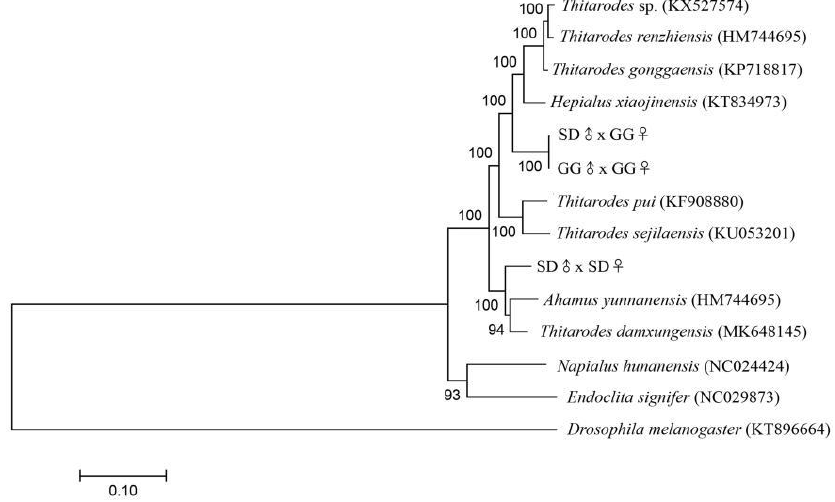
Figure 5. The phylogenetic relationship constructed by the amino acid sequence derived from 13 PCGs among 13 mitogenomes of Hepialidae insects and 1